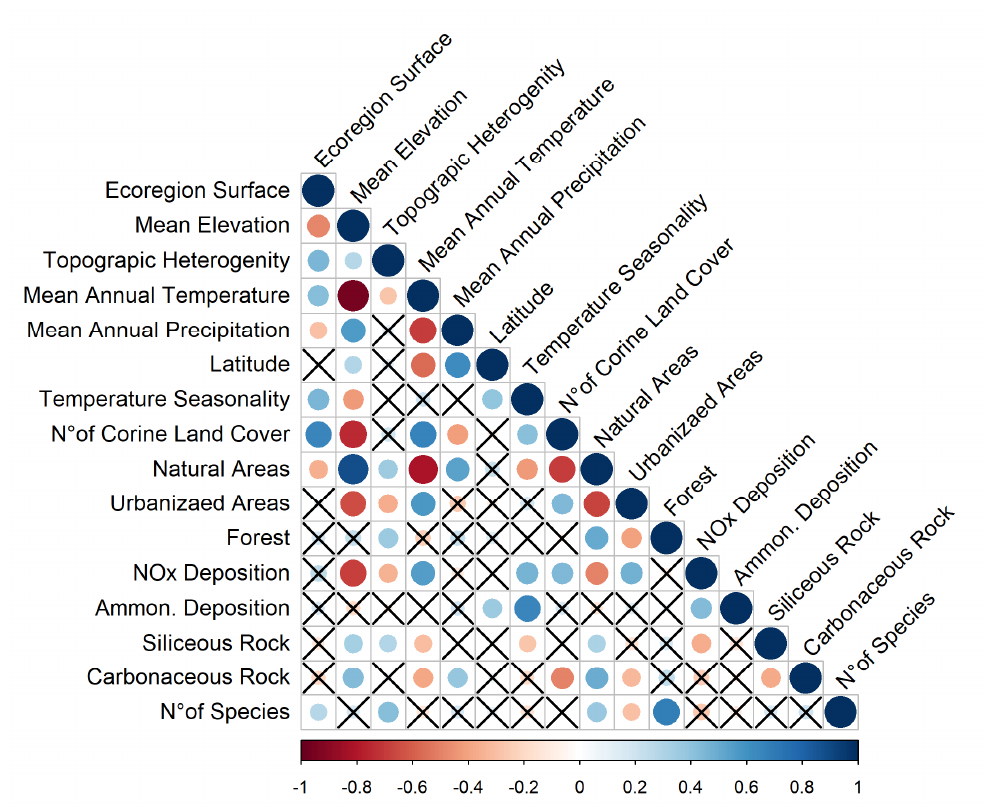
Figure 6. Correlation matrix among variables. Negative correlations are in red, positive correlations in blue. Correlations with p value > 0.01 are highlighted with a X. Strength of correlation is expressed in a scale ranging from −1 (strongly negative) to 1 (strongly positive).